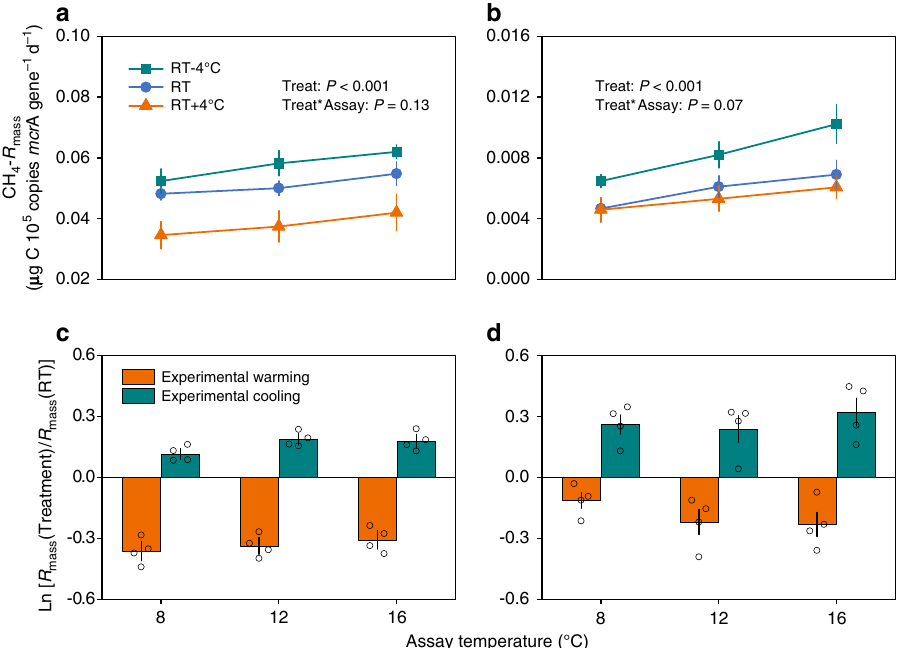
Fig. 2 The soil mass-speci fi c CH 4 respiration rate decreased under warming and increased under cooling. a , c The Greater Khingan Range; b , d The Tibetan Plateau. The abundance of mcrA gene copies was used as a proxy for the biomass of methanogens. A linear mixed-effects model was used to test for incubation and assay temperature effects on the soil mass-speci fi c CH 4 respiration (CH 4 - R mass ), the fi xed factors were the incubation temperature (RT − 4 °C, RT, and RT + 4 °C; Treat) and assay temperature (8, 12, and 16 °C; Assay), and the random factor was the spatial replicates within each wetland in a and b . For clarity the values in c and d are the natural log of the treatment (RT − 4°C or RT + 4°C): control (RT) ratios of CH 4 - R mass following 160 days of experimental warming and cooling. Ratios > 0 indicate a greater CH 4 - R mass in the treatment than in the control, and ratios < 0 indicate the reverse. RT, reference temperature (12 °C). Data are presented as mean values ± SEM, n = 4 independent soil